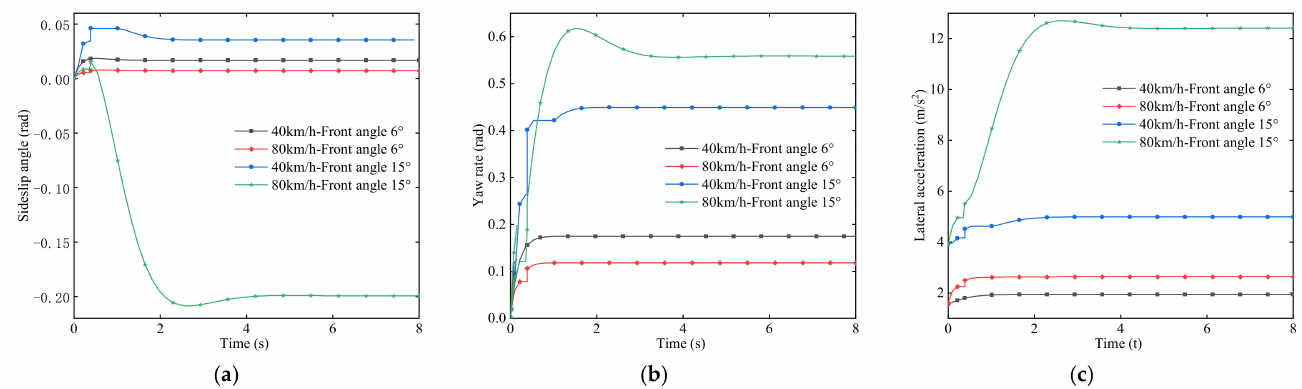
Figure 8. Simulation comparative analysis of self-adjusting double yaw rate feedback